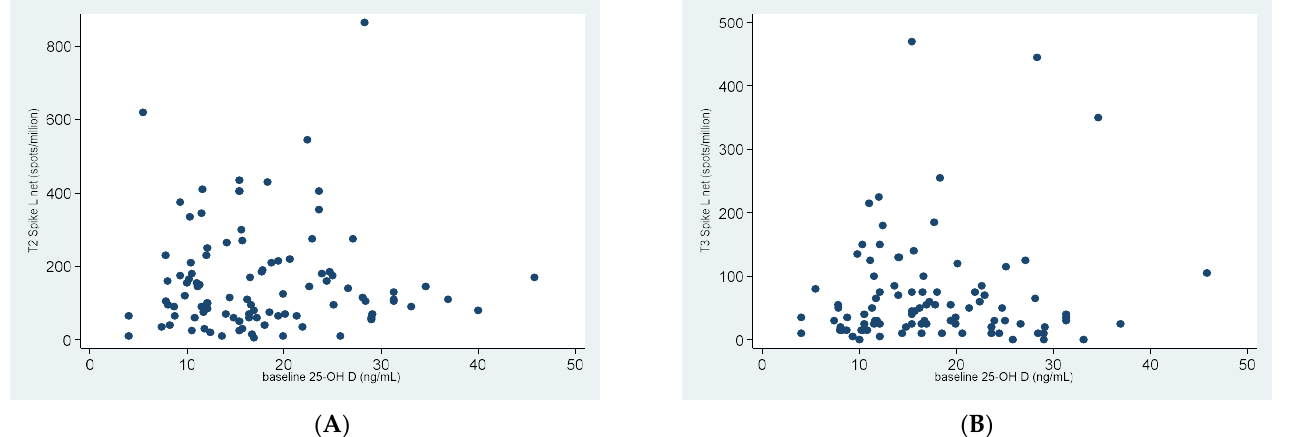
Figure 3. Correlation between 25OHD concentration at baseline and T-cell response at T2 ( A ) and T3 ( B ).